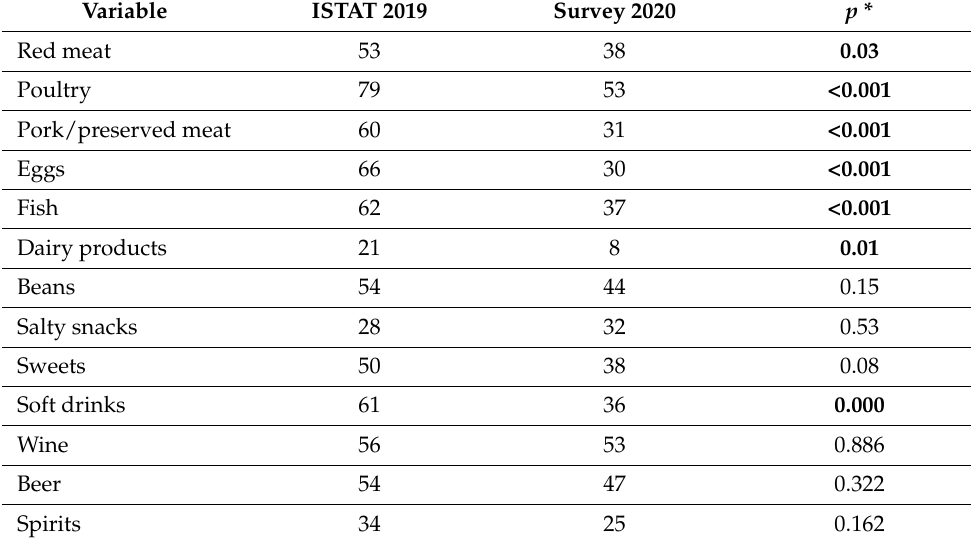
Table 5. The percentage of reported consumption of selected foods and beverages of the population according to the Italian Institute of Statistics (ISTAT) data 2019 versus the present survey data 2020 for the quantity indicated by responses of “a few times a week”.